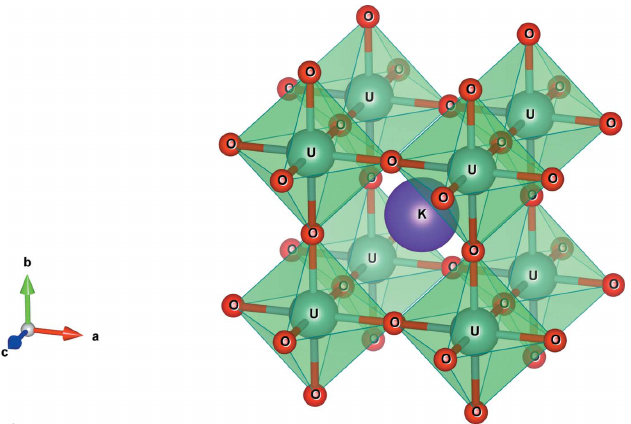
Figure 1 Representation of the KUO 3 unit cell, which exhibits an ideal, cubic perovskite structure. The oxygen atoms form a framework of corner- linked oxygen octahedra around each U atom. The K atom is positioned in the central cuboctahedral void formed by the vertices of the anion octahedra. Figure created using the VESTA3 software (Momma & Izumi,